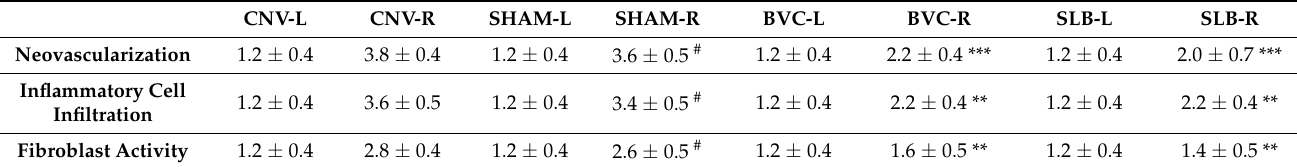
Figure 2. Rat corneal sections. ( A , C , E , G ) Normal corneal histology in CNV-L, SHM-L, CNV + B-L, and CNV + S-L groups, respectively. ( B , D ) Extensive and intense neovascularization, significant inflammatory cell infiltrations, and increased fibroblast activity in the subepithelial area in CNV-R and SHM-R groups. ( F , H ) A significant decrease in histopathological findings in CNV + B-R and CNV + S-R groups. ( H , E ) Staining, ×40, scale bar = 50 µm (arrows show inflammatory cell infiltrations, asterisk shows neovascularization areas). Table 1. The mean ( ± SD) results for histopathological findings in all groups. (Compared to